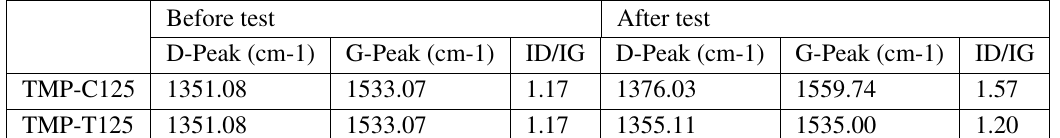
Table 2. Raman spectra shift for specimens at 125 ◦ C